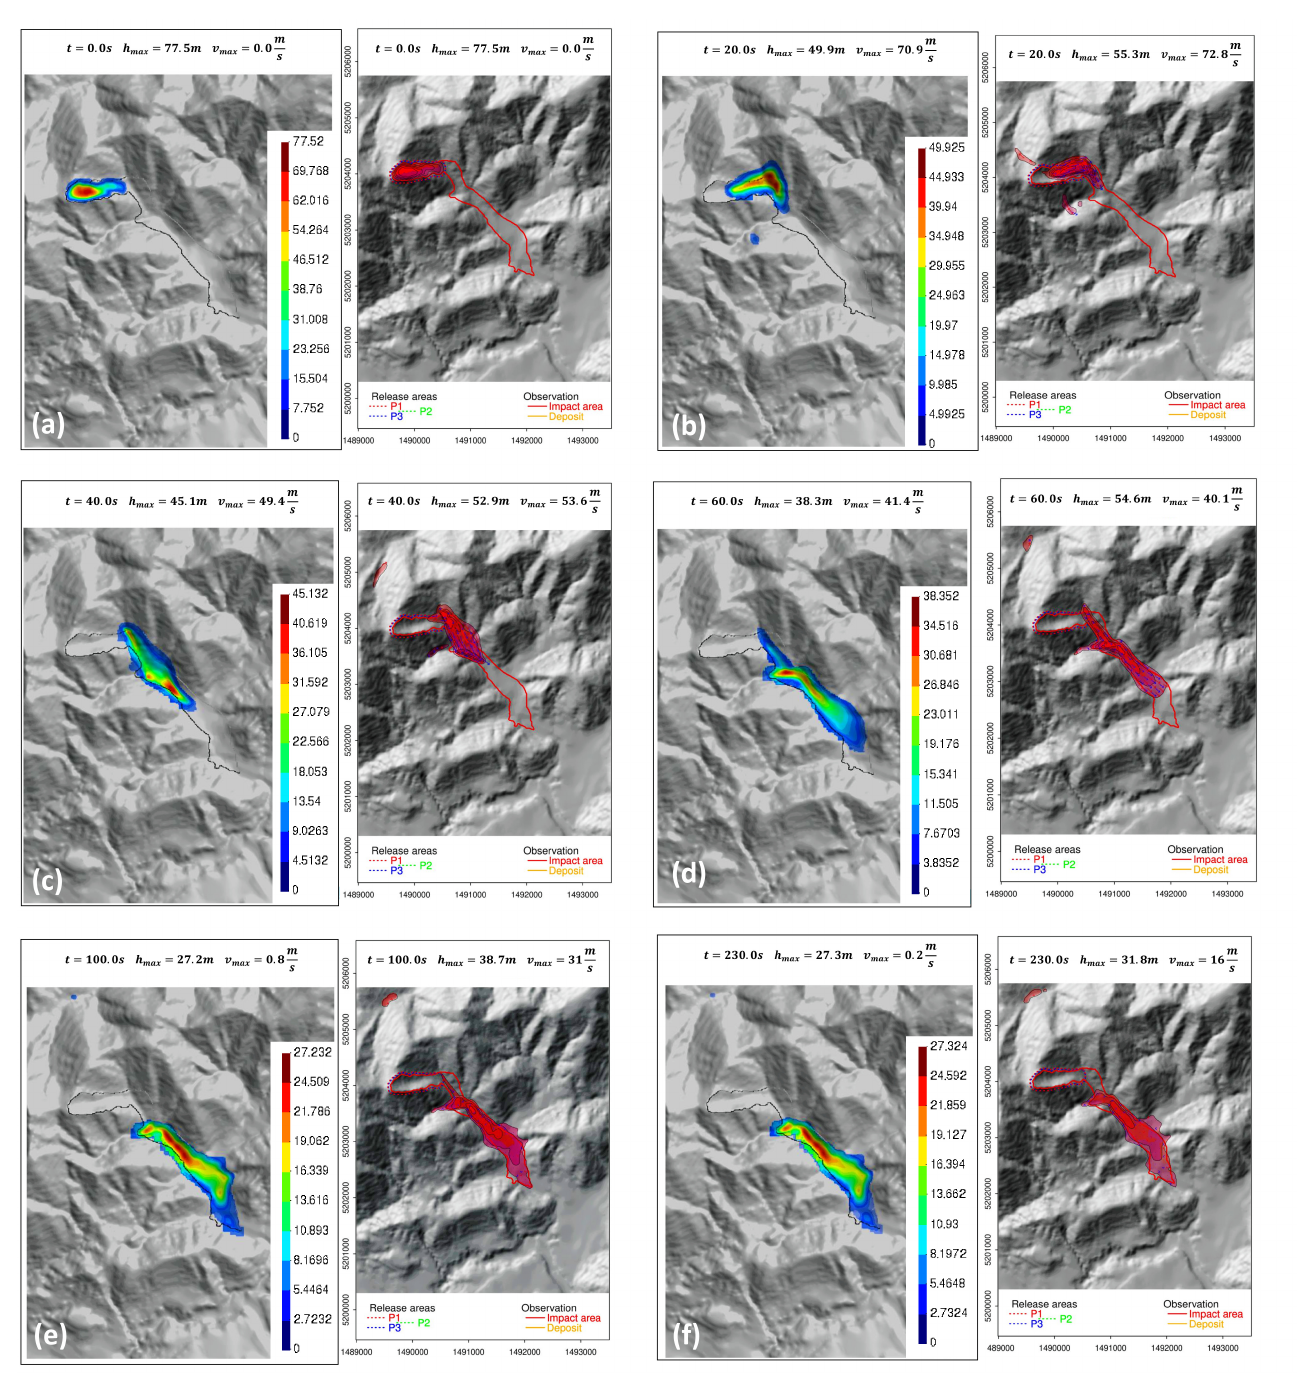
Figure 5. A comparison between two sets of code: the results on the left side were obtained with Geoglow and on the right side with r.avaflow. They show the flow propagation path, with the numerical results of flow-depth and maximum velocity at different times: ( a ) 0 s, ( b ) 20 s, ( c ) 40 s, ( d ) 60 s, ( e ) 100 s, and ( f ) 230